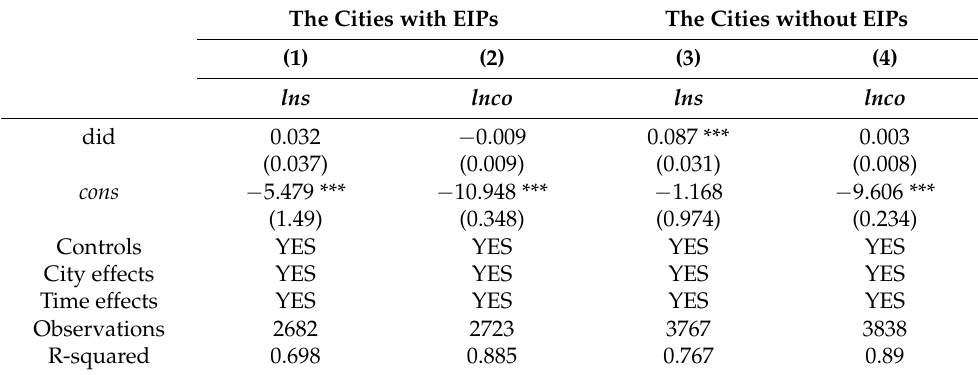
Table 8. Provincial DZs to ETZs.